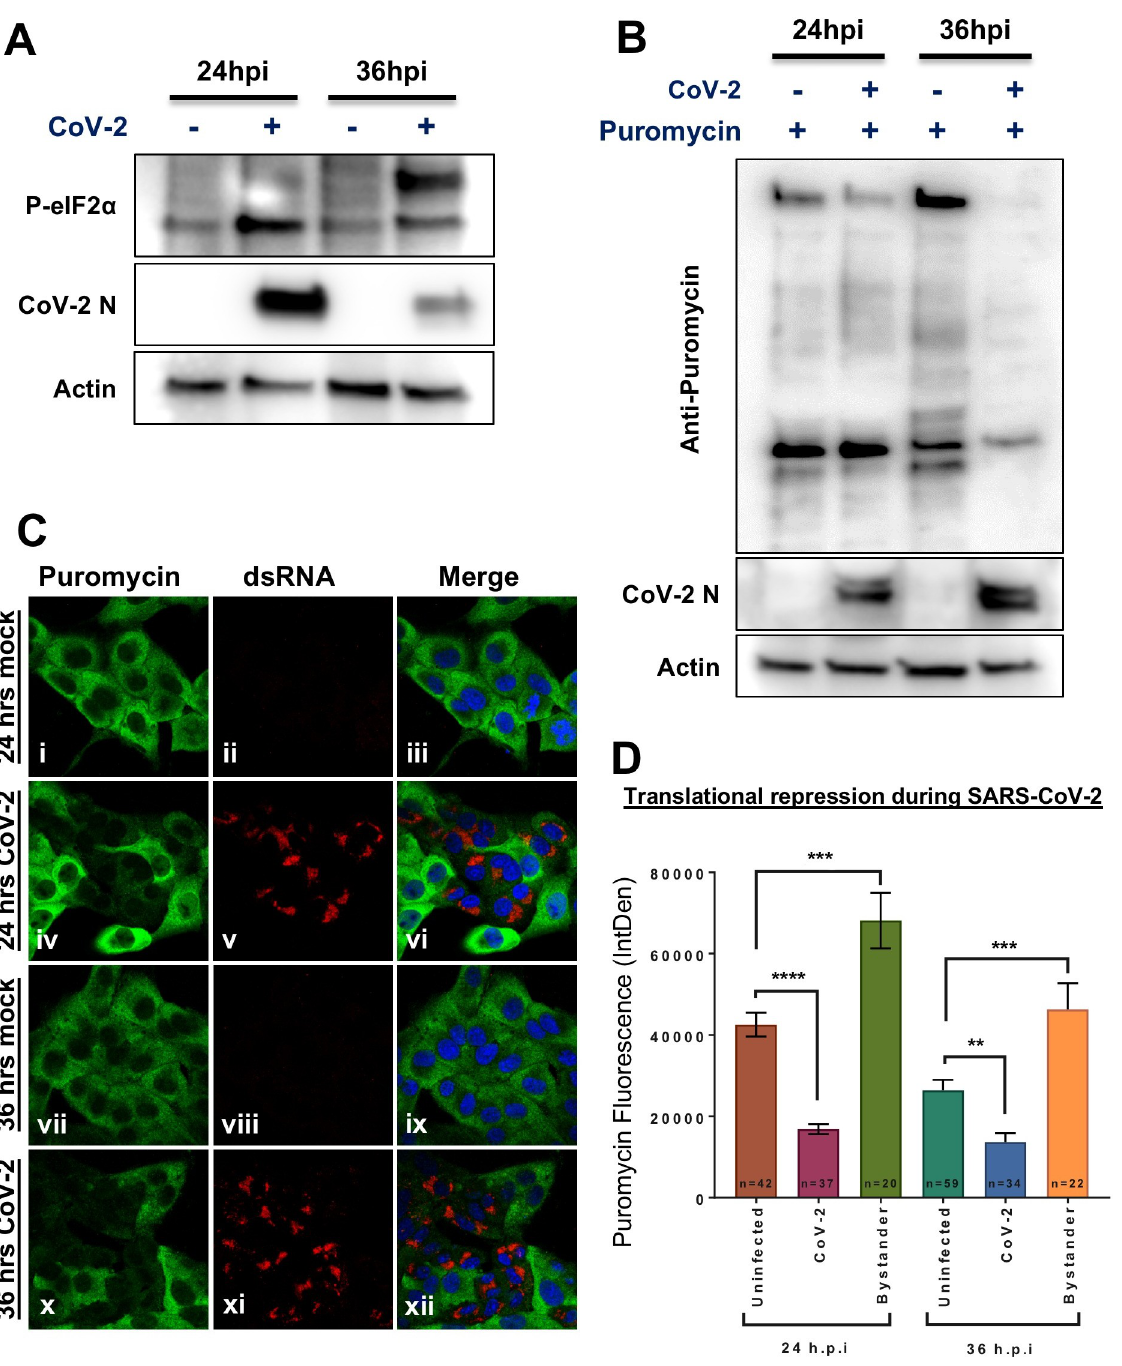
Fig 9. SARS-CoV-2 induces phosphorylation of elF2 α and the subsequent attenuation of host-cell protein translation. Vero cells were infected with SARS-CoV-2 for 24 or 36 hours before puromycin was exogenously added for 20 minutes prior to analysis. (A) Western blot depicting the increased phosphorylation of elf2 α over time (upper panel) Infected cells were detected using a SARS-CoV-2 anti-N antibodies (middle panel). Anti-actin antibodies (lower panel) served as a loading control. (B) Western blot demonstrates decreased puromycin incorporation over the course of infection: The incorporated puromycin was detected using anti-puromycin antibodies (upper panel). Infection and loading controls are shown, as was described in (A). (C) IF analysis of puromycin incorporation as detected using anti- puromycin antibodies and AF488 (green in panels i, iv, vii and x) in mock- (panels i-iii and vii-ix) and CoV-2-infected cells (panels iv-vi and x-xii) were detected using anti-dsRNA antibodies counterstained with AF594 (red in panels v and xi). (D) Quantification of puromycin incorporation in mock-infected, SARS-CoV-2-infected and bystander cells at 24 and 36 h.p.i (hours post infection). Average measurement of fluorescence +/- SEM is depicted. Significance was assessed by students t -test: � p < 0.05, �� p < 0.01, ��� p < 0.001 and ��� p < 0.0001.